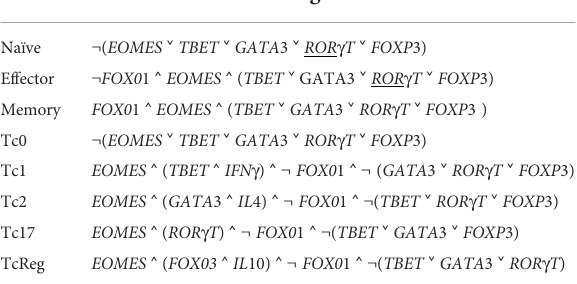
TABLE 2 Phenotype identi fi er. Node Logic